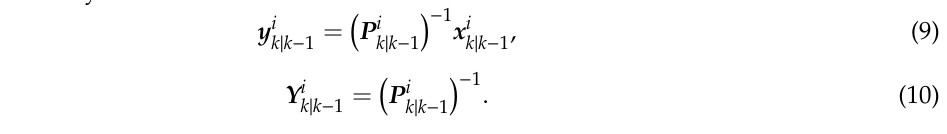
Algorithm 1 Consensus-based unscented information filter